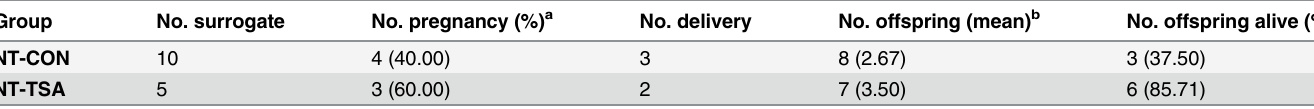
After treatment with TSA, in vivo development of cloned embryos was improved. a The pregnant rate was based on the surrogate number and one pregnant surrogate in each group was used for fetus examination. b The number of offspring was adjusted for the delivery number. c The number of alive offspring was based on the offspring